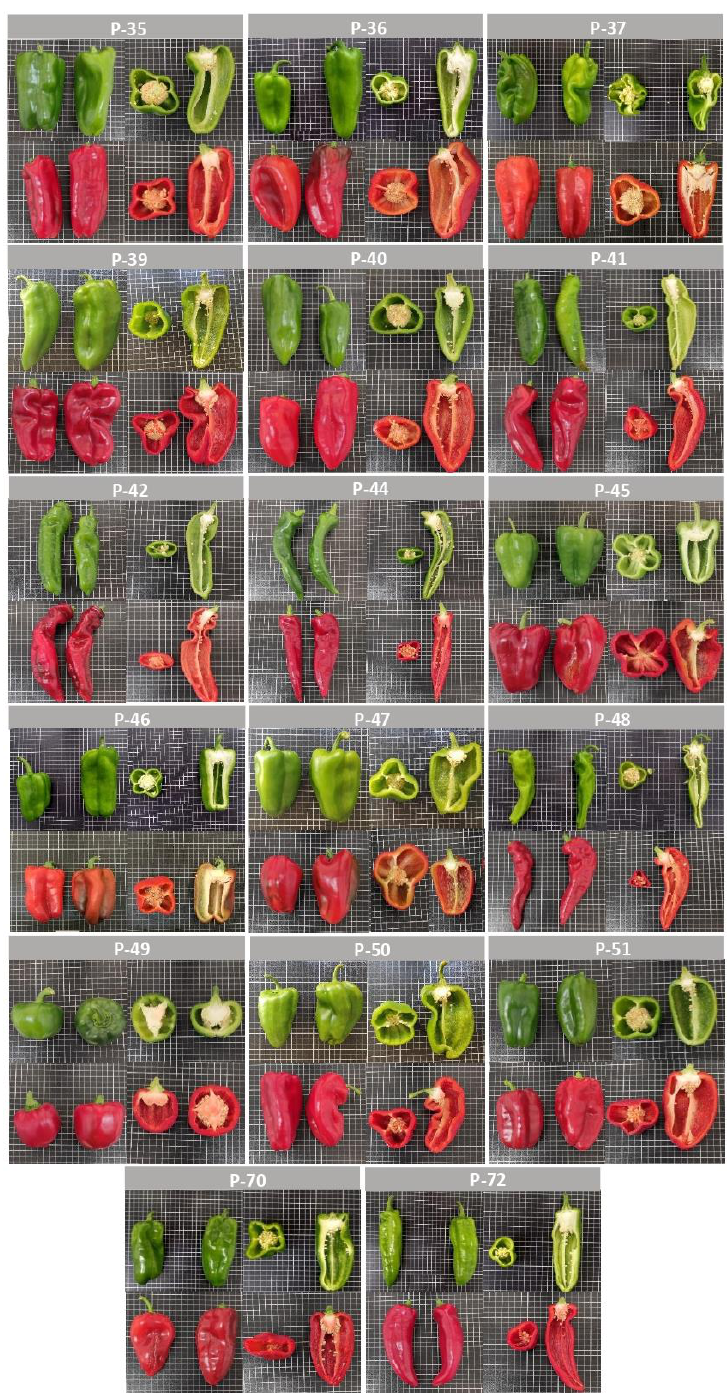
Figure 1. Pepper fruit from the 17 pepper landraces in two different ripening stages: immature: green; mature: red. The surface of each section making up the grid on which photos were taken equals 1 cm 2 .